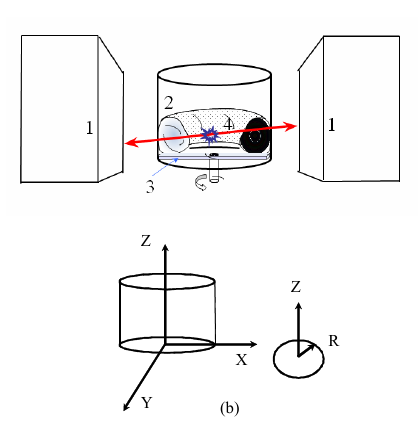
Fig.1 Experimental apparatus (1) Positron camera, (2) high shear mixer, (3) blade and (4) tracer